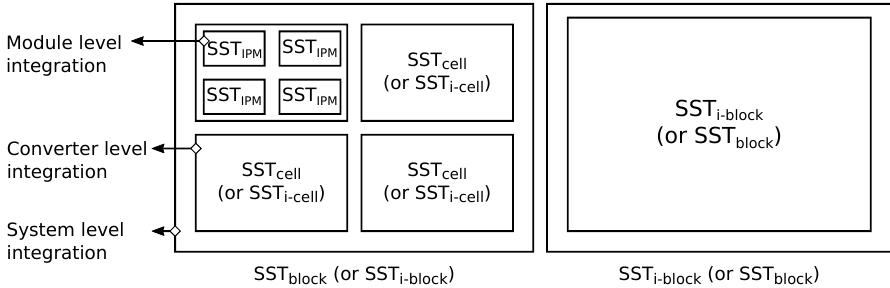
Figure 5. Different levels of integration for composition of an